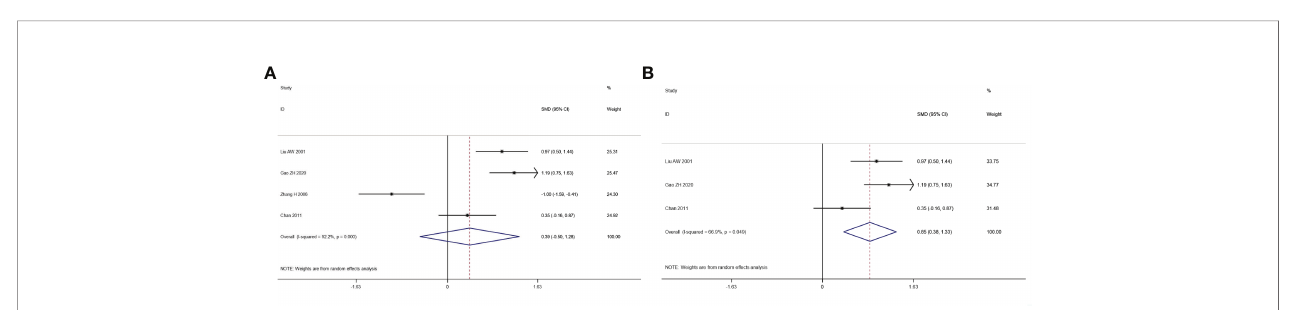
Frontiers in Oncology |